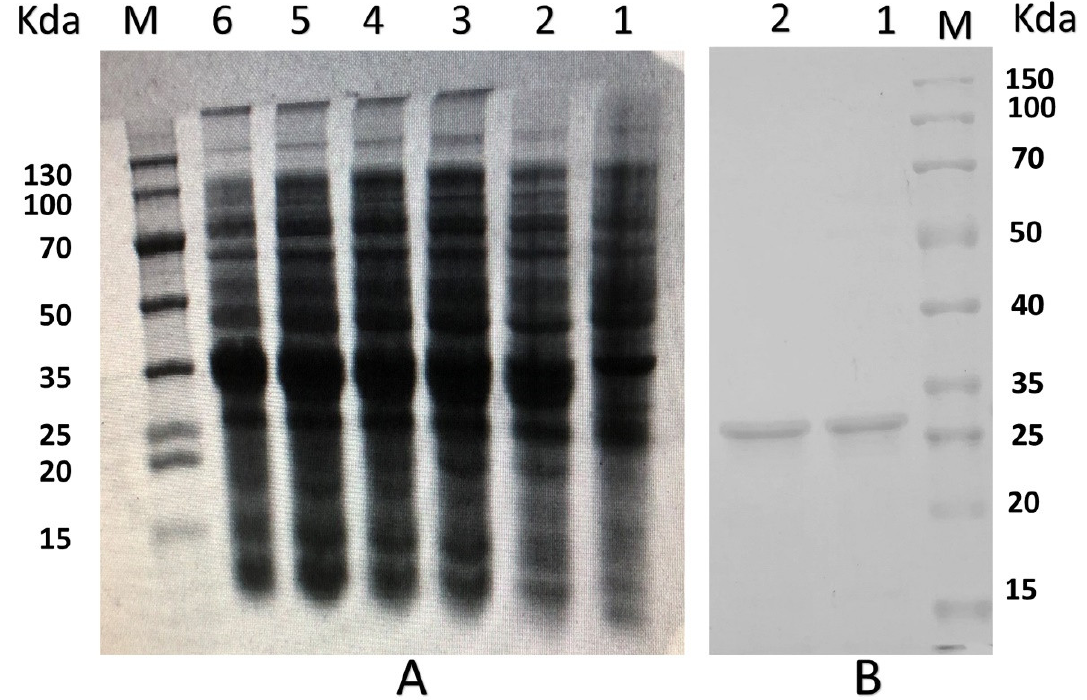
Figure 2. SDS-PAGE analysis of PNKL produced by E. coli Rosetta. ( A ), SDS-PAGE of PNKL from E. coli Rosetta. M protein markers (DL 130 kDa), Lane 1, E. coli Origami B (DE3)-pET32a (+) (non-induced), Lane 2, E. coli Origami B (DE3)-pET32a (+) induced by 1 mmol/L IPTG for 2 h at 28 ◦ C, Lane 3, E. coli Origami B (DE3)-pET32a (+) induced by 1 mmol/L IPTG for 4 h at 28 ◦ C, Lane 4, E. coli Origami B (DE3)-pET32a (+) induced by 1 mmol/L IPTG for 6 h at 28 ◦ C, Lane 5, E. coli Origami B (DE3)-pET32a (+) induced by 1 mmol/L IPTG for 8 h at 28 ◦ C, Lane 6, E. coli Origami B (DE3)-pET32a (+) induced by 1 mmol/L IPTG for 10 h at 28 ◦ C; ( B ), Purification of PNKL. M protein markers (DL 150 kDa), Lane 1-2 PNKL purified by Ni 2+ -IDA affinity chromatography.